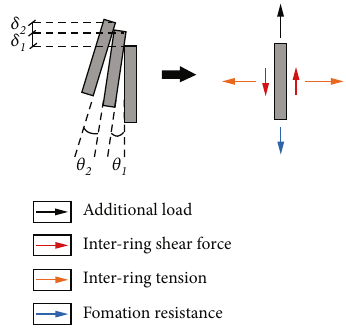
Figure 9: The stress of single segment.